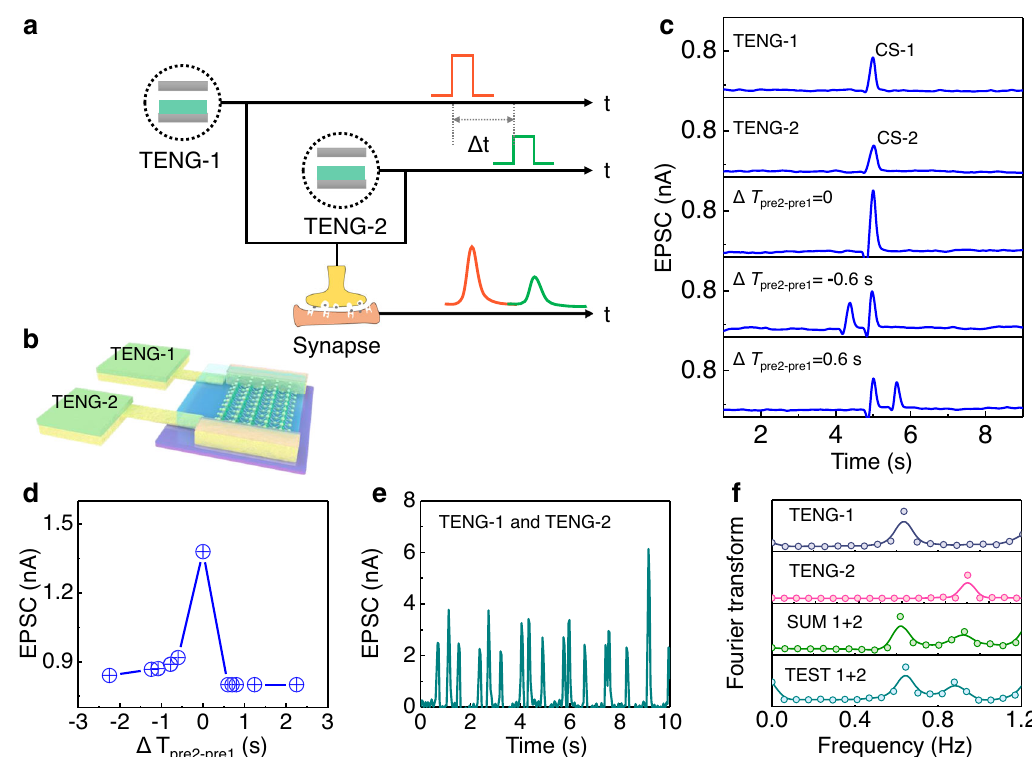
Fig. 4 The advanced spatiotemporal synaptic characteristics of CE-activated arti fi cial afferents. a Schematic illustration of EPSCs activated by dual- TENGs. b Schematic illustration of CE-activated arti fi cial afferents in dual-TENG mode. c EPSCs activated by single and paired CS actions with spatiotemporal information. d The recorded second EPSCs vs. Δ T pre2-pre1 (interval time between the fi rst and second CS actions). e The recorded EPSC responses to TENG-1 and TENG-2 simultaneously. f The extracted frequencies of the TENG-1 and TENG-2 activations after Fourier transform. The frequencies of the two activation components are clearly extracted from Fig. 4e and Supplementary Fig.